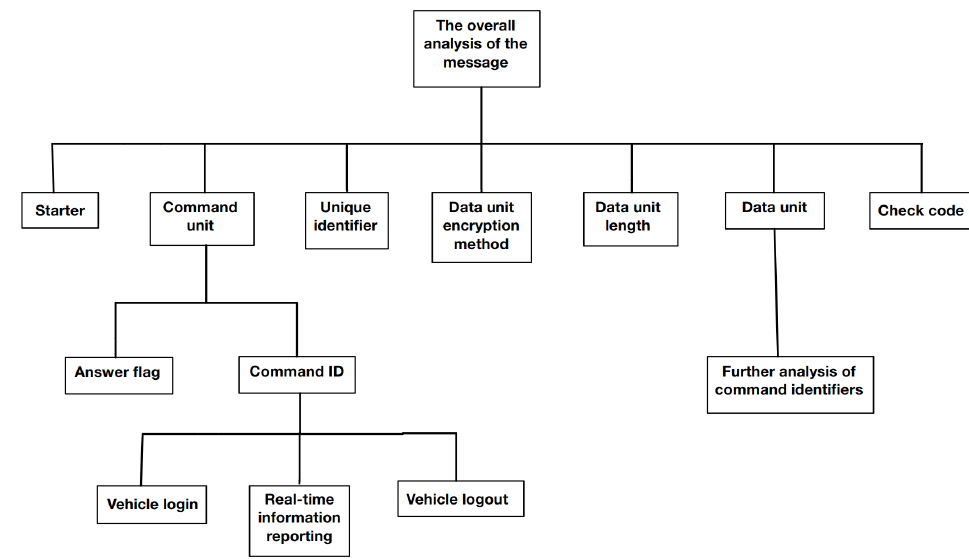
Figure 4. Global